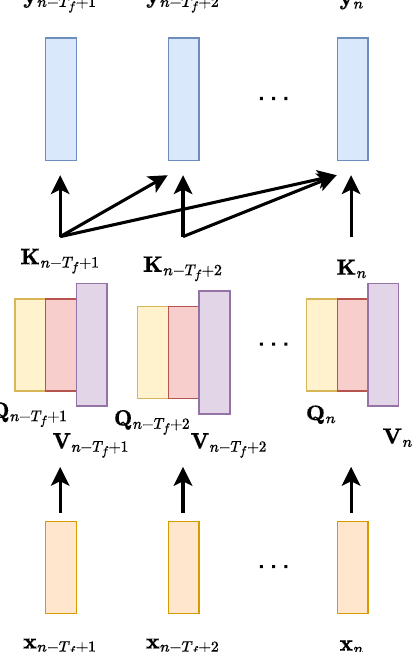
Figure 5. A graph representing dependence of output vectors y n − T the self-attention layer: keys K n − T The vectors in the self-attention layer are computed from the input vectors x n − T